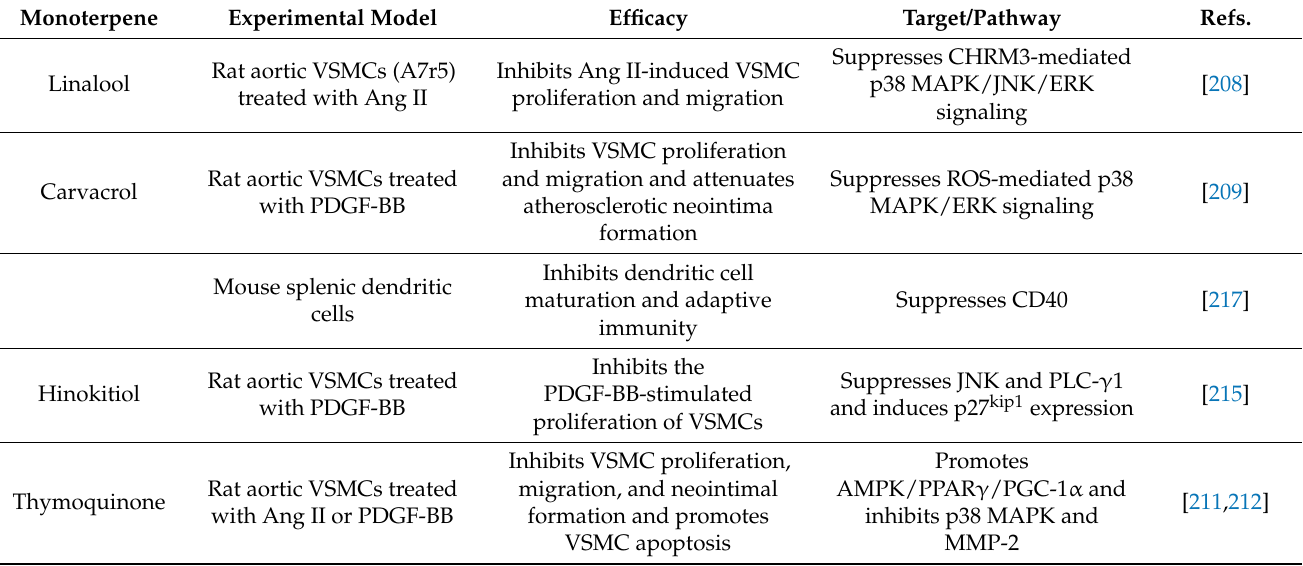
Table 7. Modulation of VSMC proliferation and migration and inhibition of dendritic cell maturation. Monoterpene Experimental Model Efficacy Target/Pathway